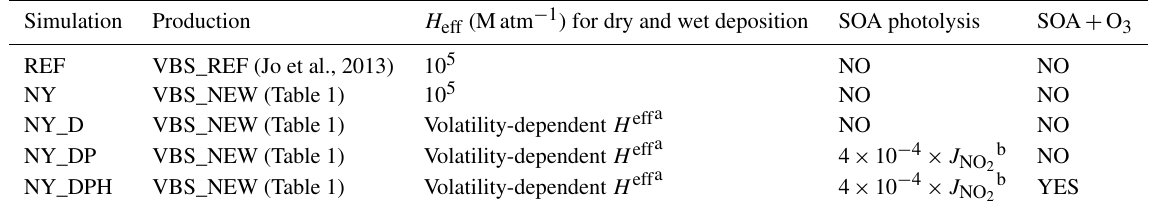
Table 4. Description of the GEOS-Chem simulations performed for years 2004–2008. Simulation